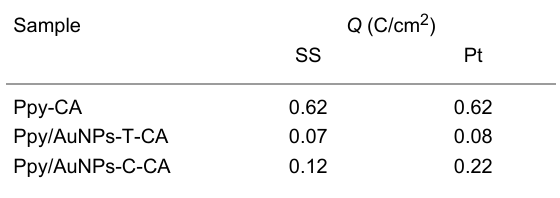
Table 1: Polymerization charges calculated for Ppy and Ppy/AuNPs composites prepared by